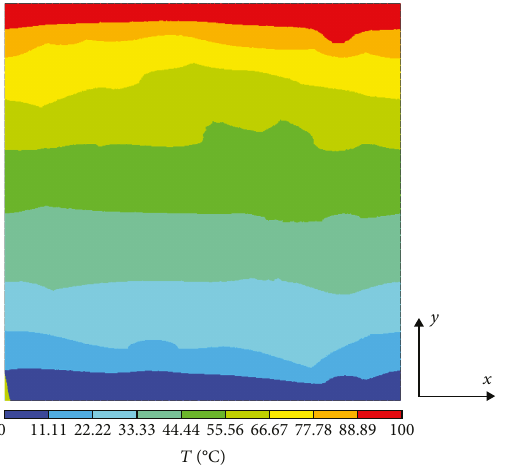
Figure 37: Pro fi le image of the temperature distribution of the fi nite element random model.